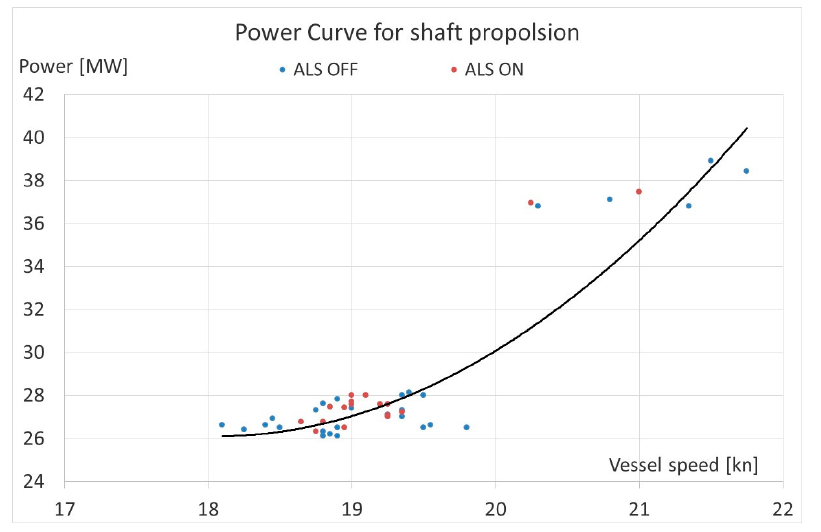
Figure 11. Average Shaft Power for given RPM against Speed from on cruise liner with diesel-electric propulsion.